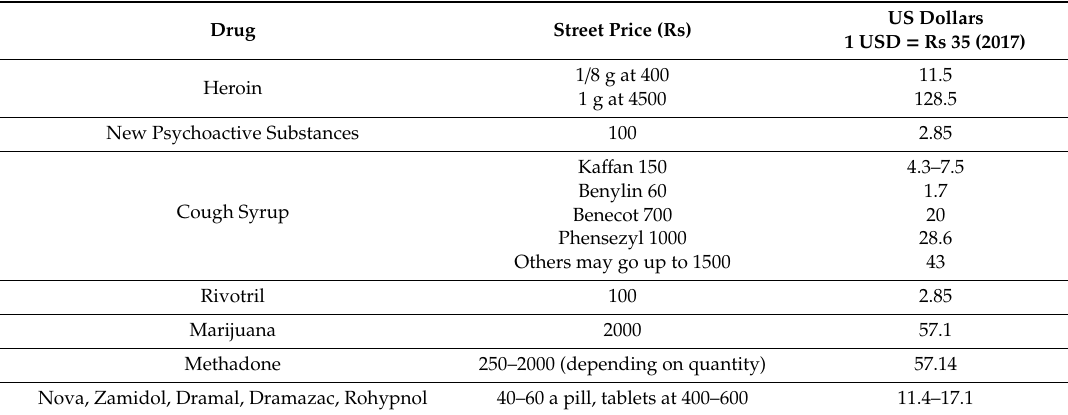
Table 2. Street price of illicit